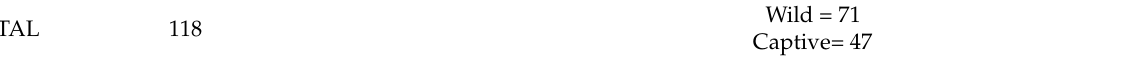
Table 1. Radius specimens used for the 3D GM analysis. M = Male, F = Female, I = Indeterminate. Species n Sex Origin Gorilla gorilla (Wild) 31 M = 17/F = 14 Gorilla gorilla (Captive) 12 M = 6/F = 6 Pan troglodytes (Wild) 25 M = 11/F = 13/I = 1 26 M = 15/F = 11 15 M = 8/F = 7 TOTAL 118